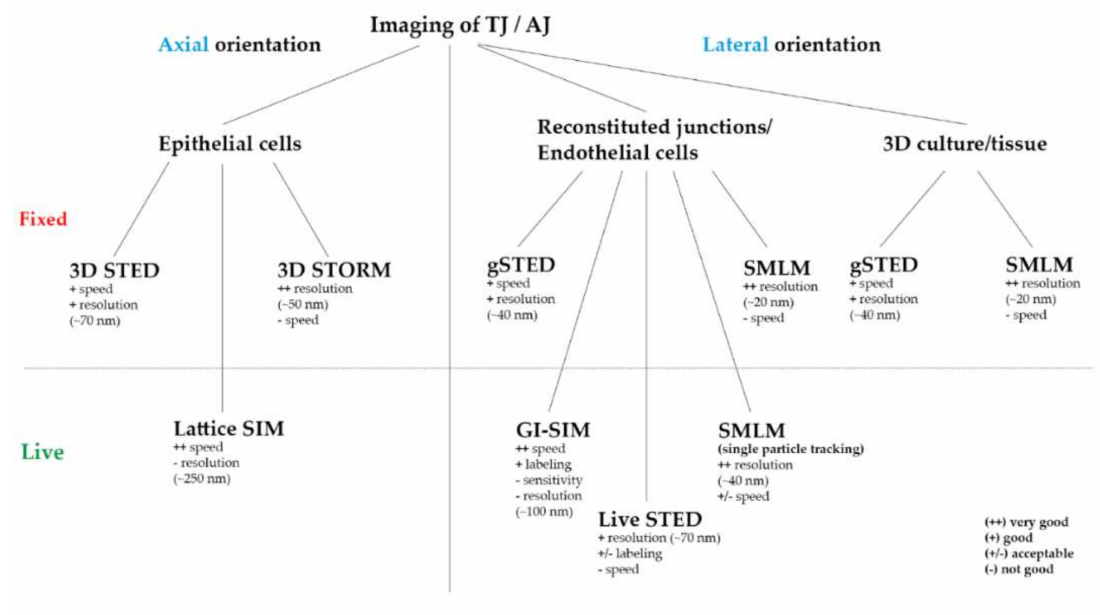
Figure 2. Practicable overview of the ideally used SRM technique for TJ and AJ imaging regarding the axial or lateral direction of the junction, the system (epi-, endothelial cells / fibroblasts / tissue), di ff erent labeling (fluorescent proteins / antibodies) and imaging (fixed / live)